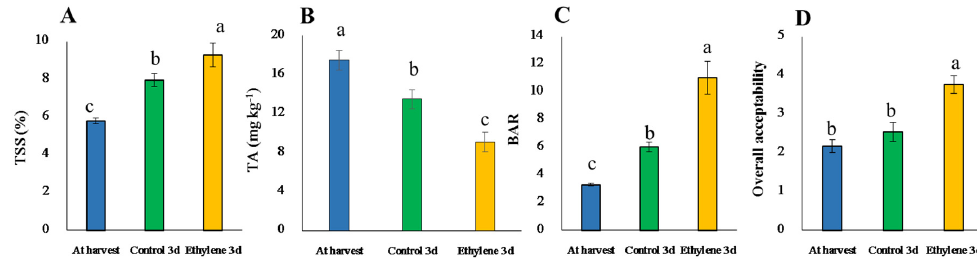
Figure 6. TSS ( A ), TA ( B ), BAR ( C ) and overall acceptability ( D ) of gold ‘Haegeum’ kiwifruit as a ff ected Figure 6. TSS (A), TA (B), BAR (C) and overall acceptability (D) of gold ‘Haegeum’ kiwifruit as by ethylene treatment during 3 days of ripening at 25 ◦ C. Vertical bars represent standard errors of the affected by ethylene treatment during 3 days of ripening at 25 °C. Vertical bars represent standard means ( n = 15). Di ff erent letters indicate significant di ff erence between di ff erent groups by Tukey’s test errors of the means ( n = 15). Different letters indicate significant difference between different groups at p ≤ by Tukey’s test at p ≤ 0.05.